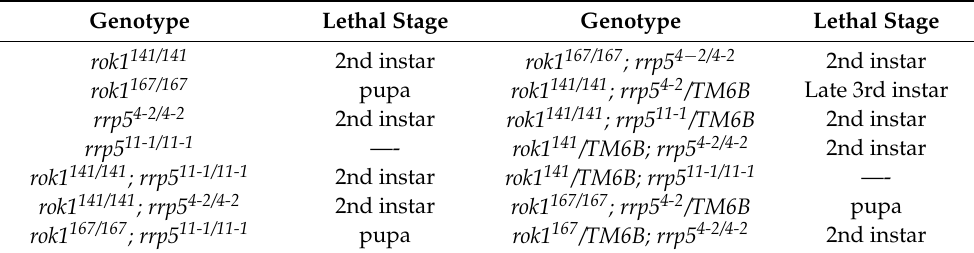
Figure 1. Mutation alleles of rok1 ( rok1 141/141 and rok1 167/167 ) and rrp5 ( rrp5 4-2/4-2 and rrp5 11-1/11-1 ) were generated by Crispr/Cas9. ( A ) Molecular nature of the mutations generated by Crispr/Cas9. Two null mutation alleles of rok1 and rrp5 ( rok1 141/141 and rrp5 4-2/4-2 ) were generated with the early termination of translation, and the point mutation allele of rok1 167/167 lost amino acids in the ATP-binding site, while rrp5 11-1/11-1 lost them in a non-functional domain. ( B ) The expression levels of rok1 and rrp5 were measured in w 1118 , rok1 141/141 , rok1 167/167 , and rrp5 4-2/4-2 . Thirty second-instar larvae of w 1118 , rok1 141/141 , rok1 167/167 , and rrp5 4-2/4-2 were pooled as one sample. The initial copy numbers of rok1 and rrp5 were calculated from the CT value of each cDNA sample after adjusting by the copy number of Act5C . *** indicate significant differences between the two groups at the p < 0.001 level (unpaired t -test, SPSS). Each point represents the mean ± SD ( n = 3). Table 1. The lethal phenotypes of rok1 and rrp5